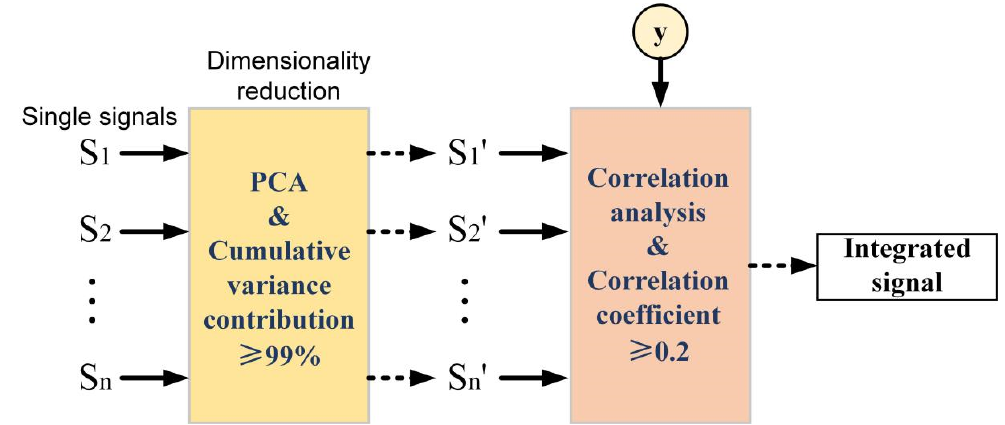
Figure 6. Multi-signal fusion process.